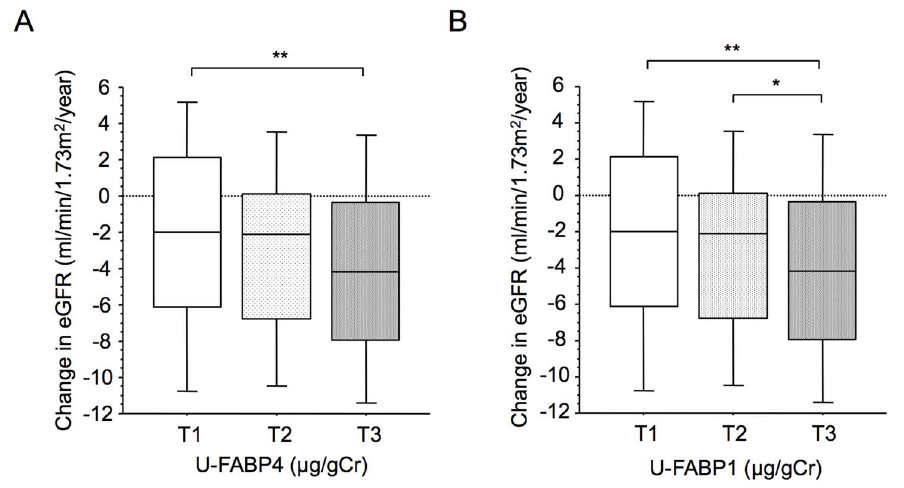
Fig. 2. Change in eGFR in tertiles of urinary FABP4 and FABP1. A, B. Of the 392 recruited subjects, 325 subjects could be followed up in 2012, and change in eGFR from 2011 to 2012 (mL/min/1.73 m 2 /year) shown by box plots was compared among three groups divided by tertiles of urinary FABP4 (U-FABP4) (A) and urinary FABP1 (U-FABP1) (B). Tertile of U-FABP4 consists of low (T1 , 0.04 m g/gCr, n 5 108), middle (0.04 # T2 , 0.30 m g/gCr, n 5 108), and high (T3 $ 0.30 m g/gCr, n 5 109) groups. Tertile of U-FABP1 consists of low (T1 , 4.27 m g/gCr, n 5 108), middle (4.27 # T2 , 7.15 m g/gCr, n 5 108), and high (T3 $ 7.15 m g/gCr, n 5 109) groups. *P , 0.05, **P , 0.001.